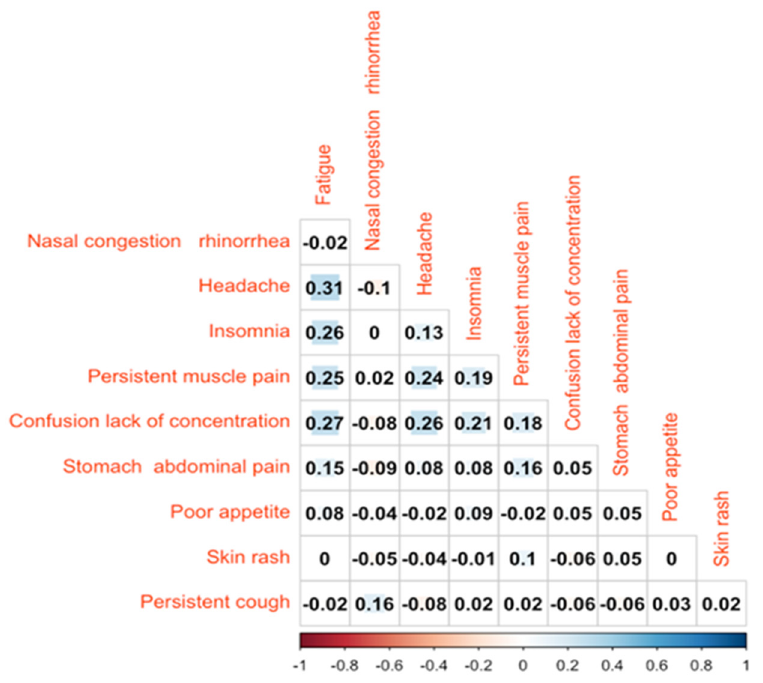
Figure 1. The coexistence of the ten most commonly reported symptoms. Table 3. Persistent symptoms comparing Omicron and original variants at 1-5 months’ follow-up. Only the children followed up within the same time period were